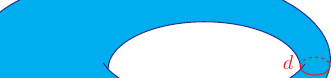
FIG. 2. The 1-systole on a torus sys to the code distance of a 2D quantum error-correcting code or topological order defined on the torus, such as the toric code